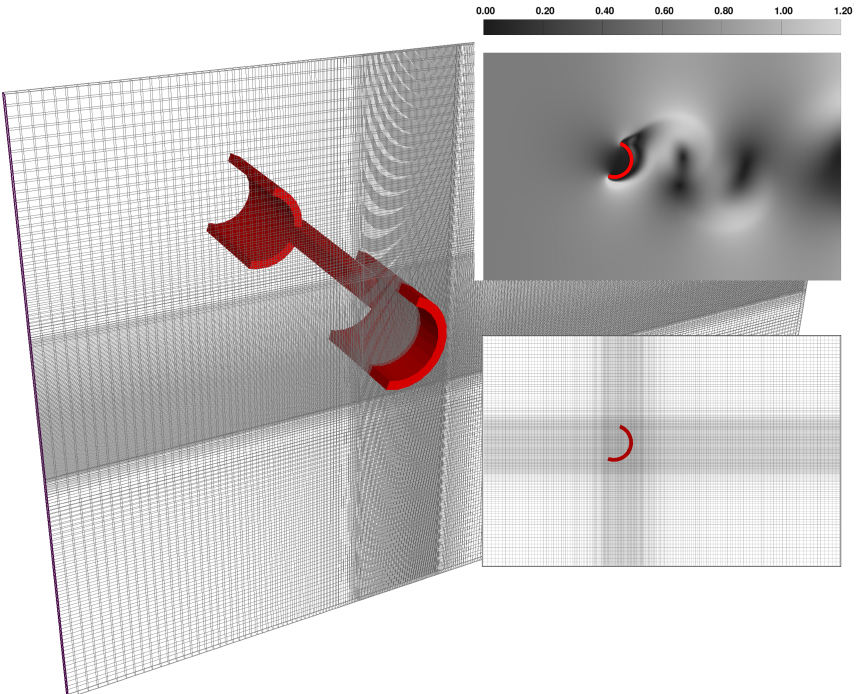
Figure 2. 3D and 2D view (lower inset) of the non-uniform grid employed in the CFD code. Upper inset: example of flow field (velocity magnitude in m/s). The VI is depicted in